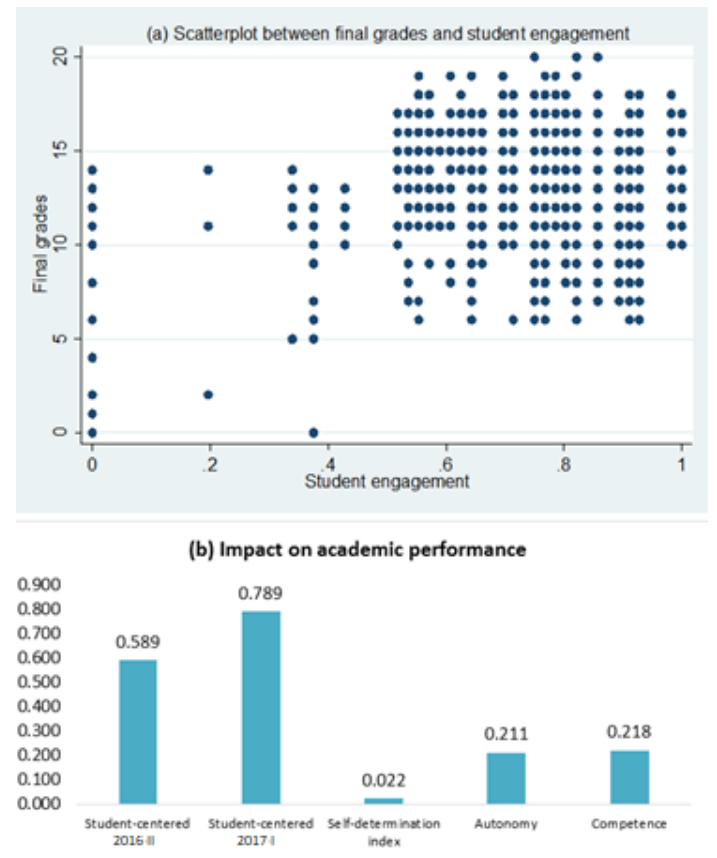
Fig. 5. Samples of data dashboards illustrating the level of achievement of two UEM-specific goals: (a) student engagement (as accounted by an adaptation of The Classroom Obser- vation Protocol for Undergraduate in STEM[10]) and its correlation with final grades. Using a Tobit regression model, the data shows a positive and statistically significant effect (p<0.05) of 0.803, meaning that a one point higher level of engagement could improve a student's final grade by 0.803 points. (b) the impact on academic perfor- mance of a perception of student-centeredness, self-determination, autonomy and com- petence. The graph exhibits the positive effect of these variables, with student- centeredness showing the strongest and most statistically significant (p<0.01) effect on academic